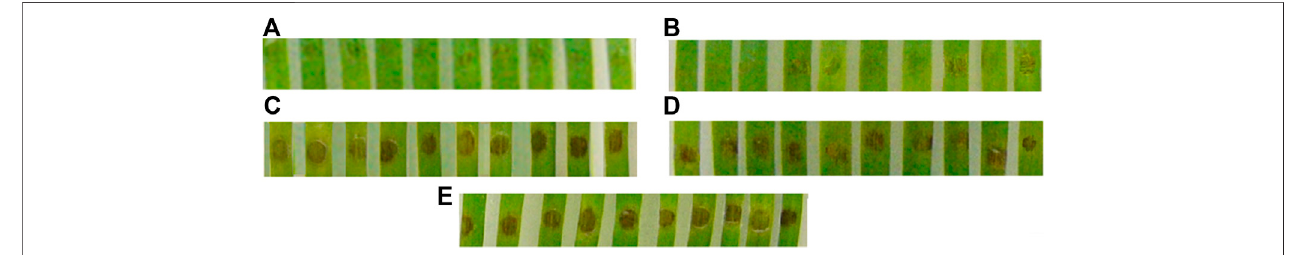
FIGURE 7 | – Mitigation of disease symptoms on leaf sections cut from detached wheat leaves due to refolded enzyme application. Upper (distal) pats of leaf sections inoculated with a suspension of Parastagonospora nodorum conidia containing: (A) Chit19, (B) Chit19 Δ ChBD; (C) , (D) — lower (basal) parts of the same leaf sectionsinoculatedwithconidiasuspendedinNa-acetatebuffer; (E) basalpartsofcontrolleafsectionsinoculatedwith P.nodorum conidiasuspendedindistilledwater. Representative photographs of one of three